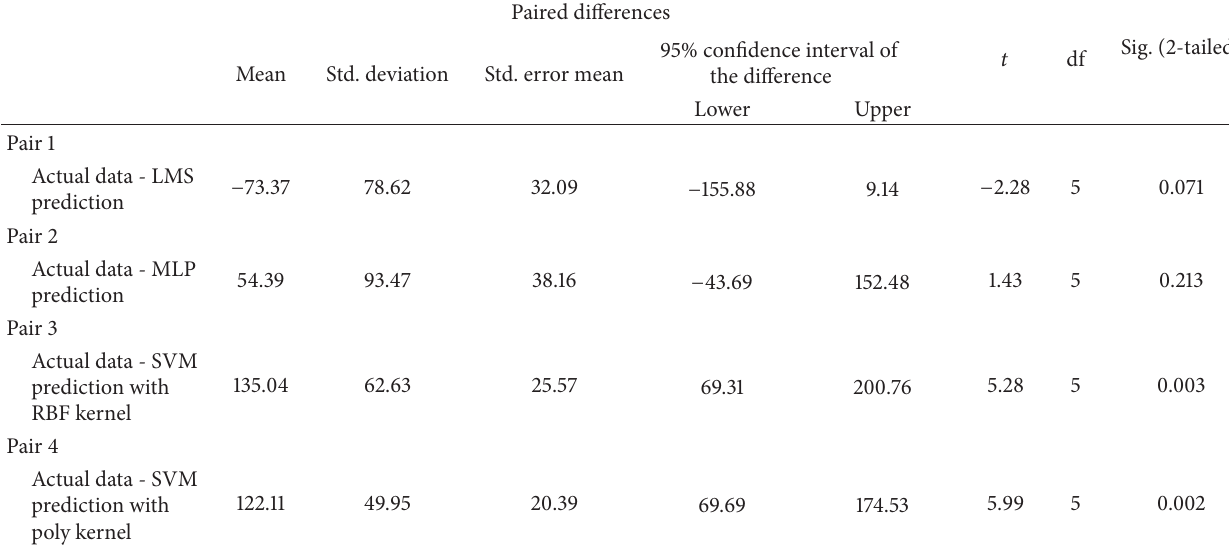
Table 9: Paired samples